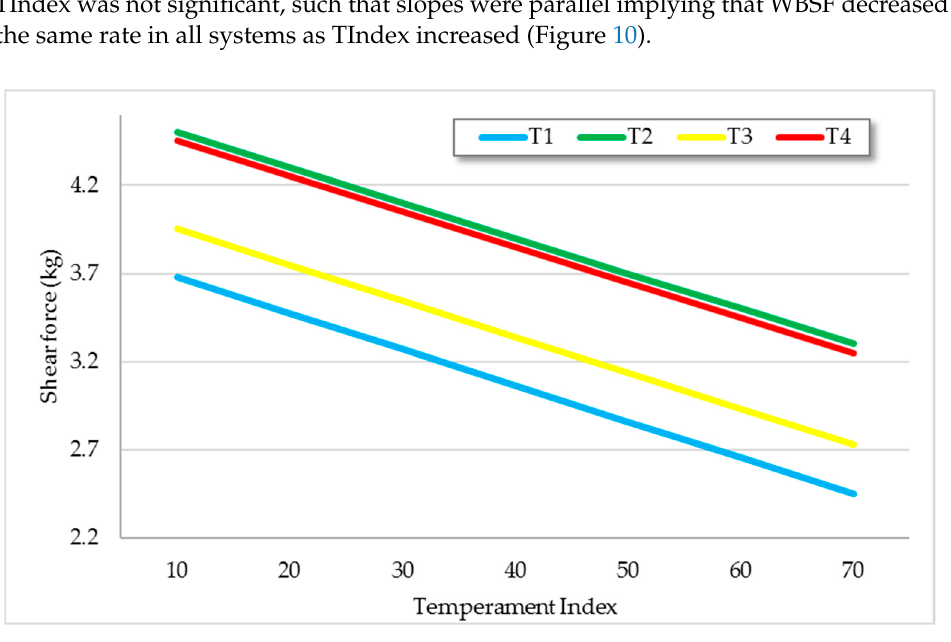
Figure 10. Shear force (kgF) with 20 aging days according to TIndex. Trendlines per treatment, estimated by regression analysis ( R 2 = 0.30).